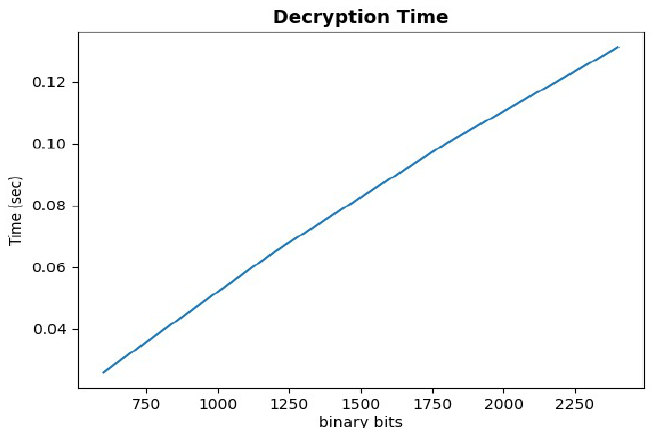
Figure 8. Computational complexity for decryption.